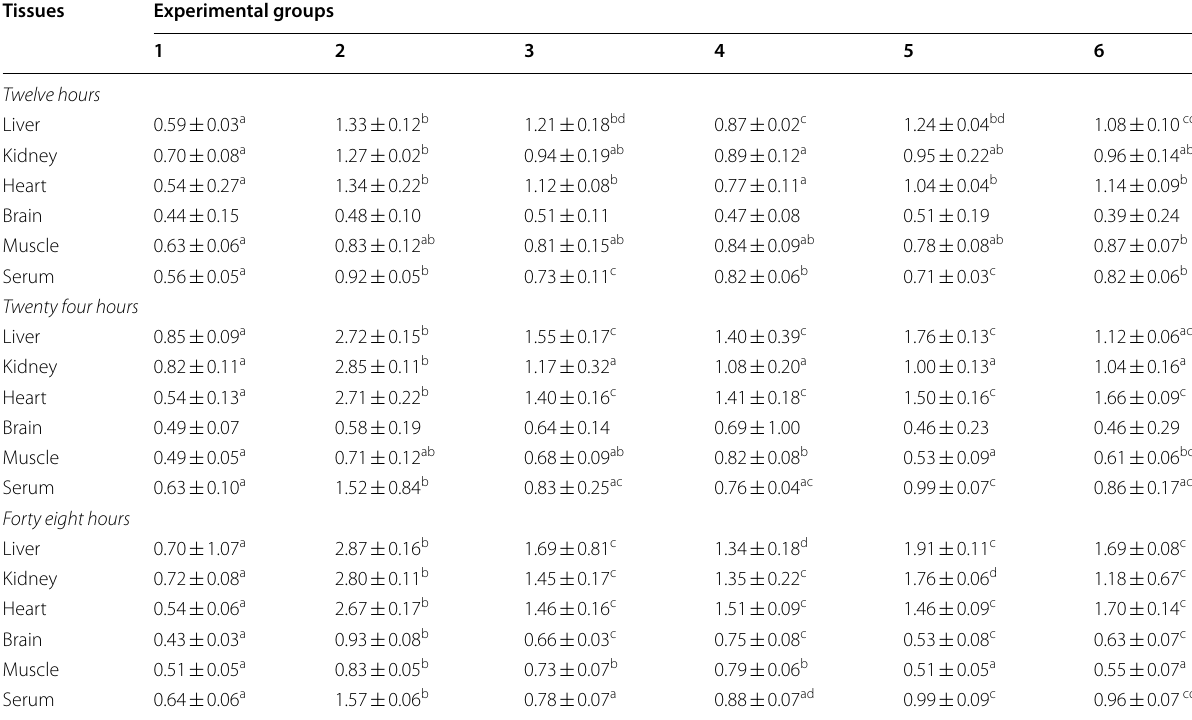
Table 1 Effect of palm oil fractions on levels of malondialdehyde (MDA) in tissue and serum of rats administered